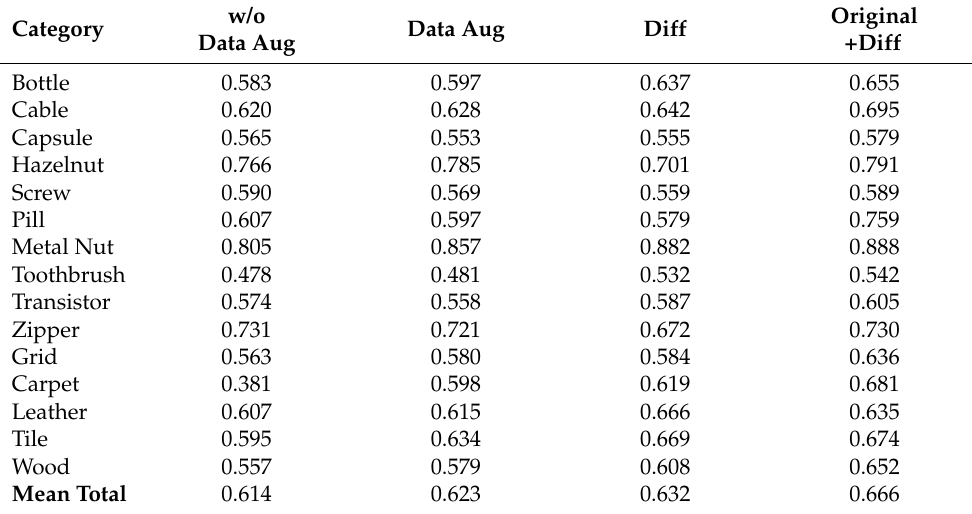
Table 4. Ablation study of data augmentation and different types of input. We report the IoUs of feeding the original image with and without data augmentation, the augmented different image, and the augmented original image combined with the different